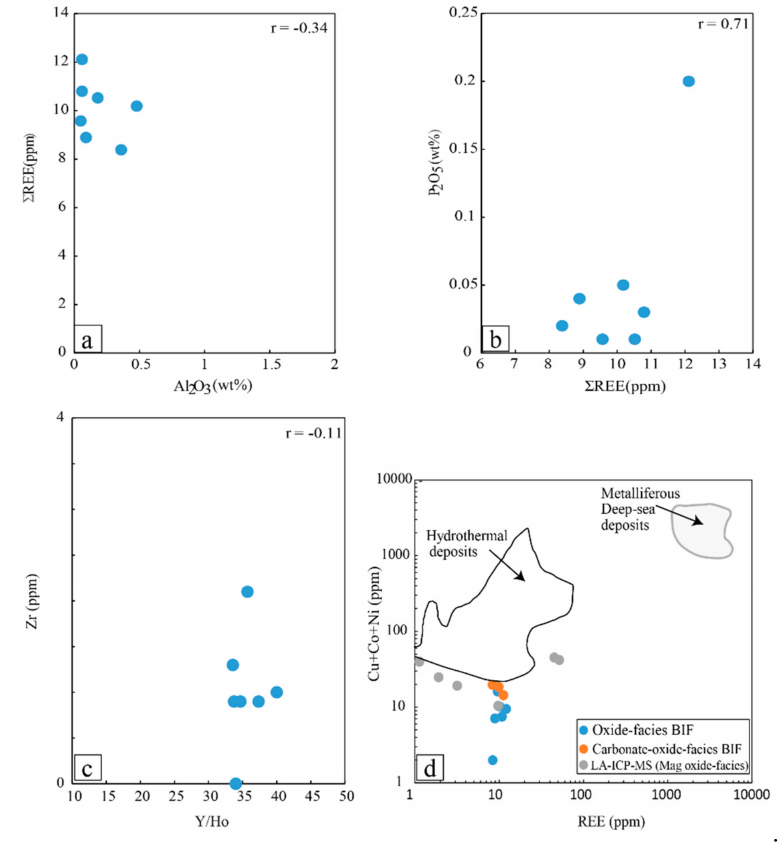
Figure 15. Plots of ( a ) Σ REE vs. Al 2 O 3 ; ( b ) P 2 O 5 vs. Σ REE; ( c ) Y/Ho vs. Zr; ( d ) (Co+Ni+Cu) vs. Σ REE (after [5]) for the Nabeba